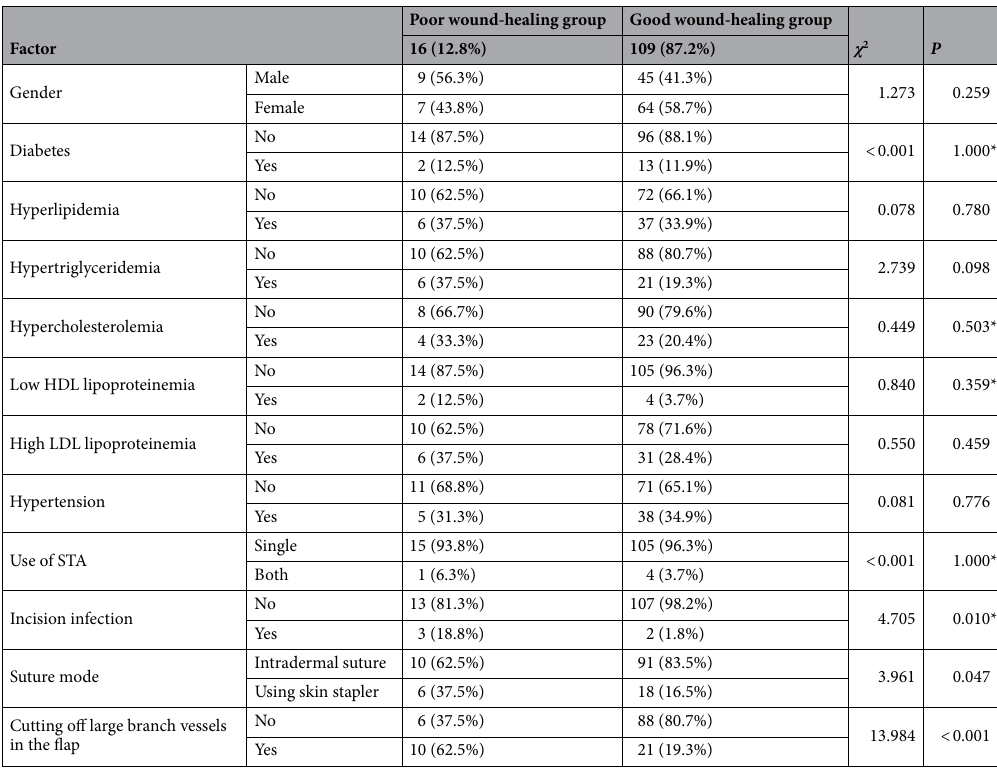
Table 3. Comparison of qualitative factors. *Continuity